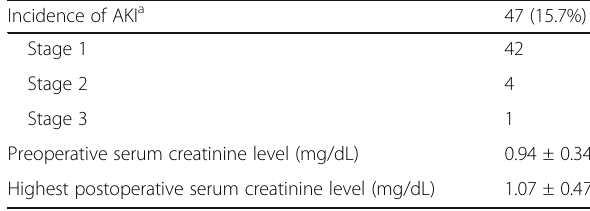
Table 1 Postoperative AKI and perioperative creatinine value Incidence of AKI a